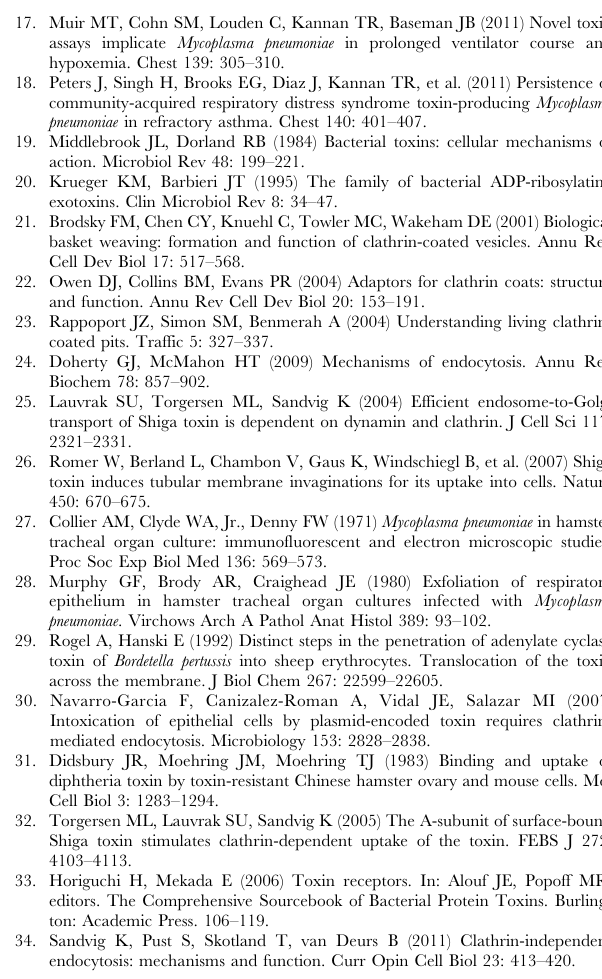
Figure S3 Effect of clathrin depletion on rCARDS toxin uptake by HeLa cells. C-siRNA or S-siRNA transfected HeLa cells were incubated with 10 m g/ml of rCARDS toxin (A–B) or 10 m g/ml of Tf (C-D) at 37 u C. Immunofluorescence labeling was performed using rabbit polyclonal anti-CARDS toxin antibodies (1:1000) or anti-Tf mouse antibodies (1:500) along with corre- sponding secondary antibodies tagged with Alex-Flour 633 (Red). Nuclei were labeled with DAPI (Blue). All images of 0.5 micrometer z-section and cross sectional views were obtained using confocal laser scanning